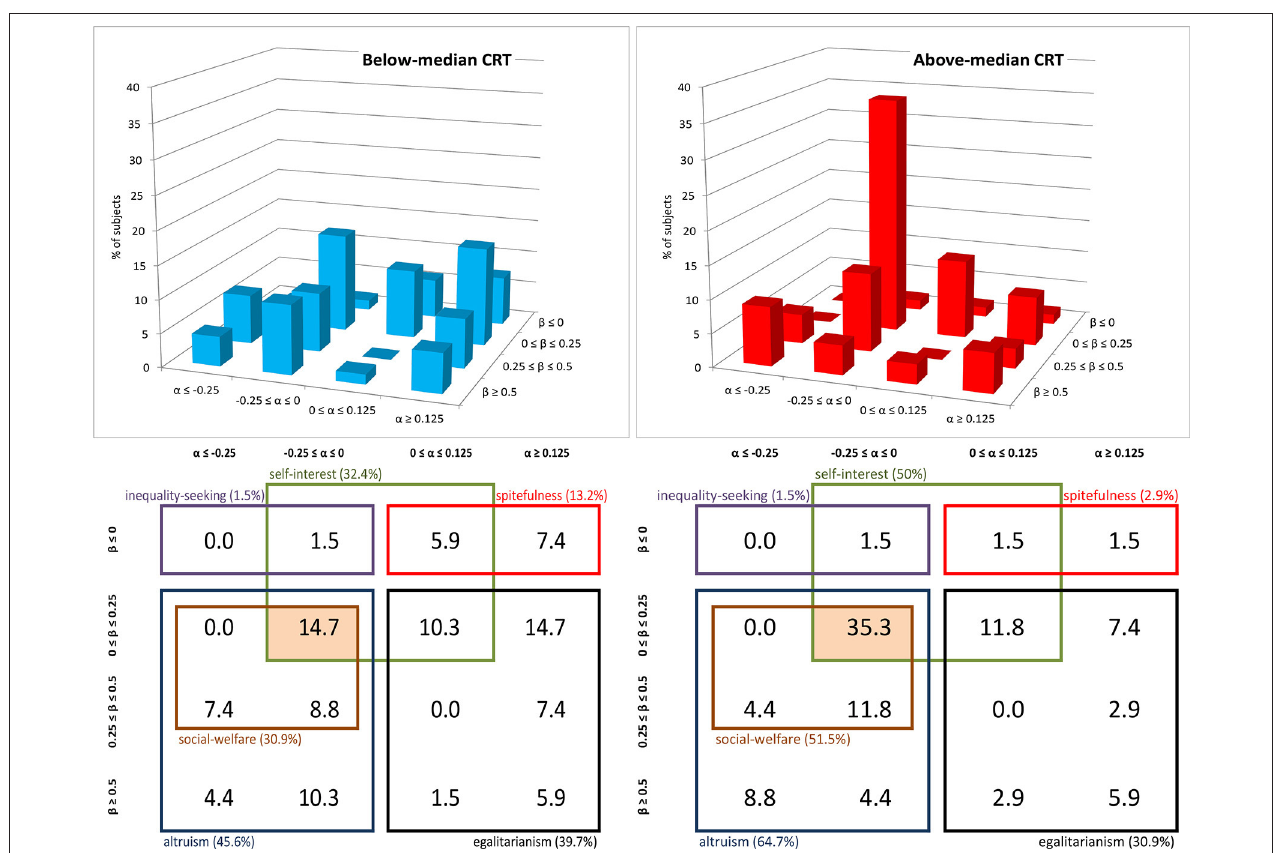
FIGURE 5 | Classification of subjects according to the envy and compassion parameters, by CRT groups (Study 2). The figure displays the % of subjects that can be classified according to each combination of α and β and the social preferences which are consistent with each category, broken down into below-median ( n = 68 ) and above-median ( n = 68 ) CRT score